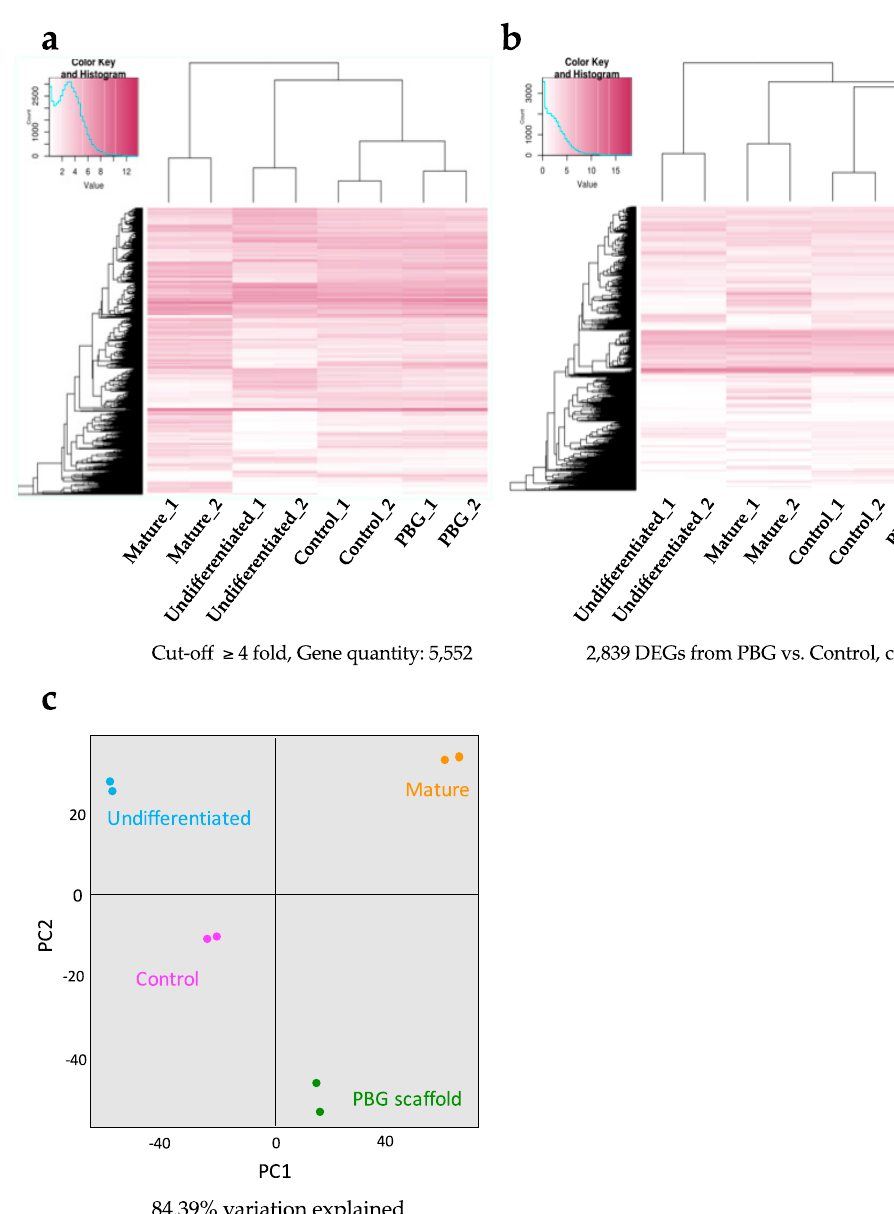
Figure 4. The transcriptome differences between hiPSC-derived RGC-like cells cultured on the cover glass and PBG scaffold on Day 34. ( a ) RNA-seq is performed in duplicate in each group (undifferentiated, mature, control, and PBG scaffold), and the expression profiles (5552 genes) of each group show consistent changes, which are illustrated by heat map. The relative expression levels are presented by using a color key. ( b ) Differentially expressed genes were identified between the PBG scaffold group and control group from RNA-seq analysis (2839 genes, fold change ≥ 2, adjusted p -value < 0.05). Global gene expression patterns of differentially expressed genes between four groups are shown by heat map. The relative expression levels are presented by using a color key. ( c ) Two-thousand-eight-hundred-and-nine differentially expressed genes from hiPSC-derived RGC-like cells cultured on cover glass (control) and PBG scaffold are analyzed by principal components analysis. PC1 and PC2 that represent 84.39% of variability are plotted on the x- and y-axis,